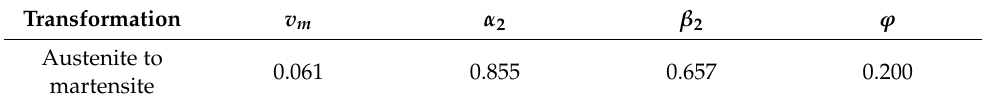
Table 2. Parameters used for non-diffusive phase transformations. Transformation v m α 2 β 2 ϕ Austenite to martensite